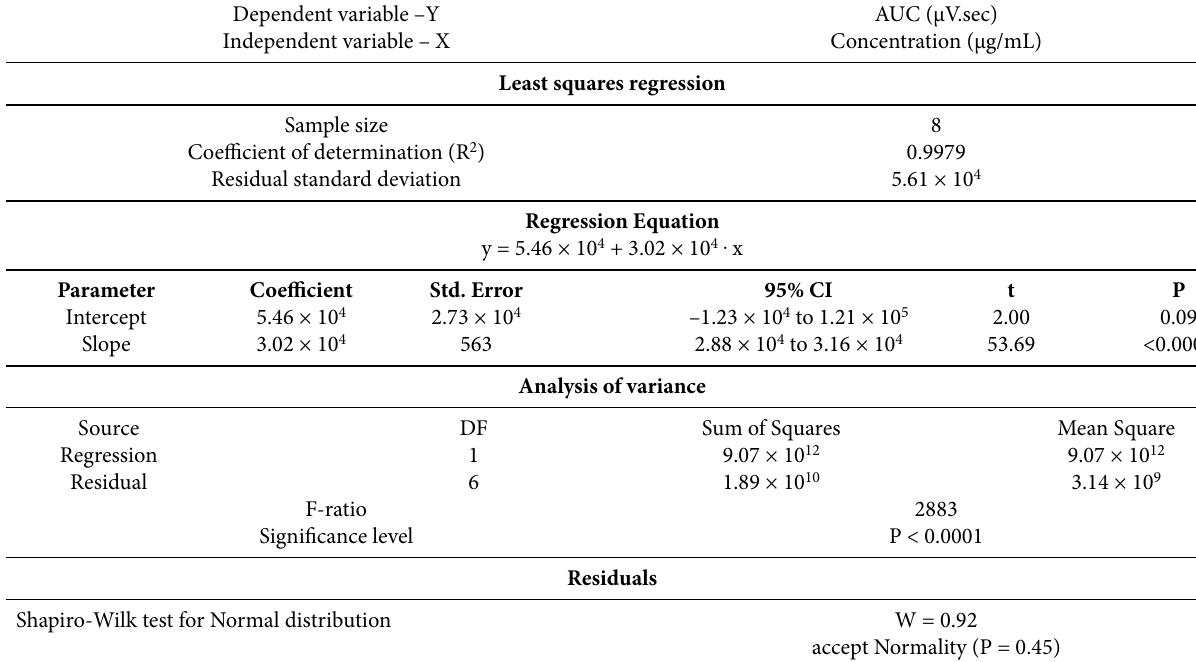
Table 3. Precision and accuracy for estimation of curcumin in mobile phase using HPLC Theoretical Intra- and inter-day precision concentration